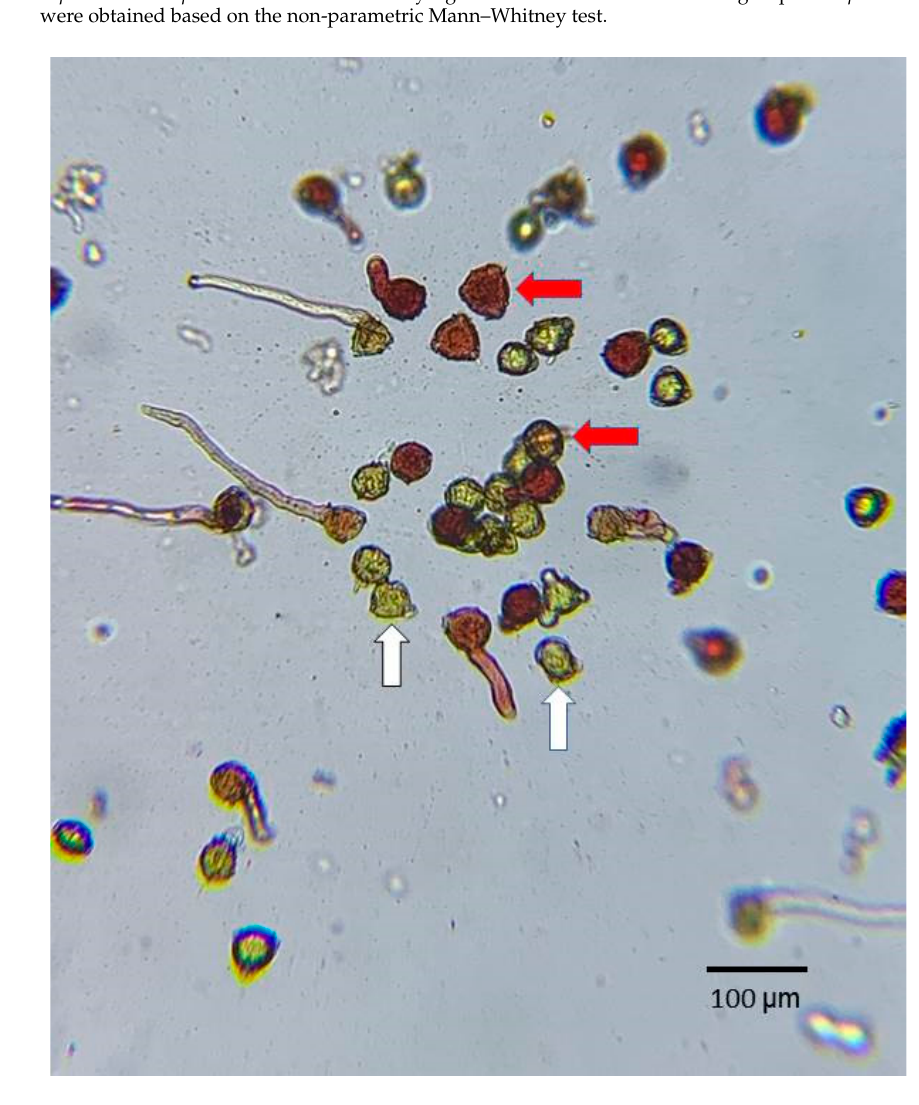
Figure 3. Pollen viability distribution for 75 tea varieties.